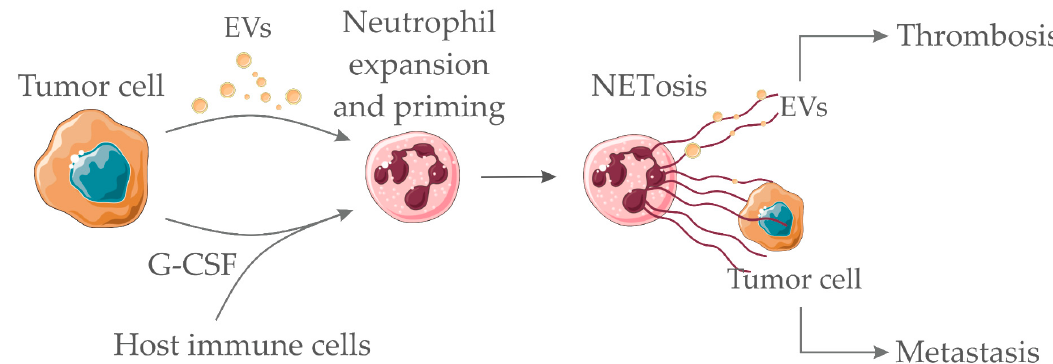
Figure 2. Pro-hemostatic interactions between tumor cell-derived soluble factors/EVs and neutrophils. Tumor-derived EVs and/or tumor/host-derived soluble factors (such as granulocyte colony-stimulating factor (G-CSF) and other cytokines) interact with neutrophils promoting the neutrophil extracellular trap (NET) formation process (NETosis). NETs act as scaffolds for the binding of procoagulant tumor-derived EVs, therefore, amplifying thrombus formation. NETs may also entrap tumor cells, thus favoring metastasis. Servier Medical Art, https://smart.servier.com/, was